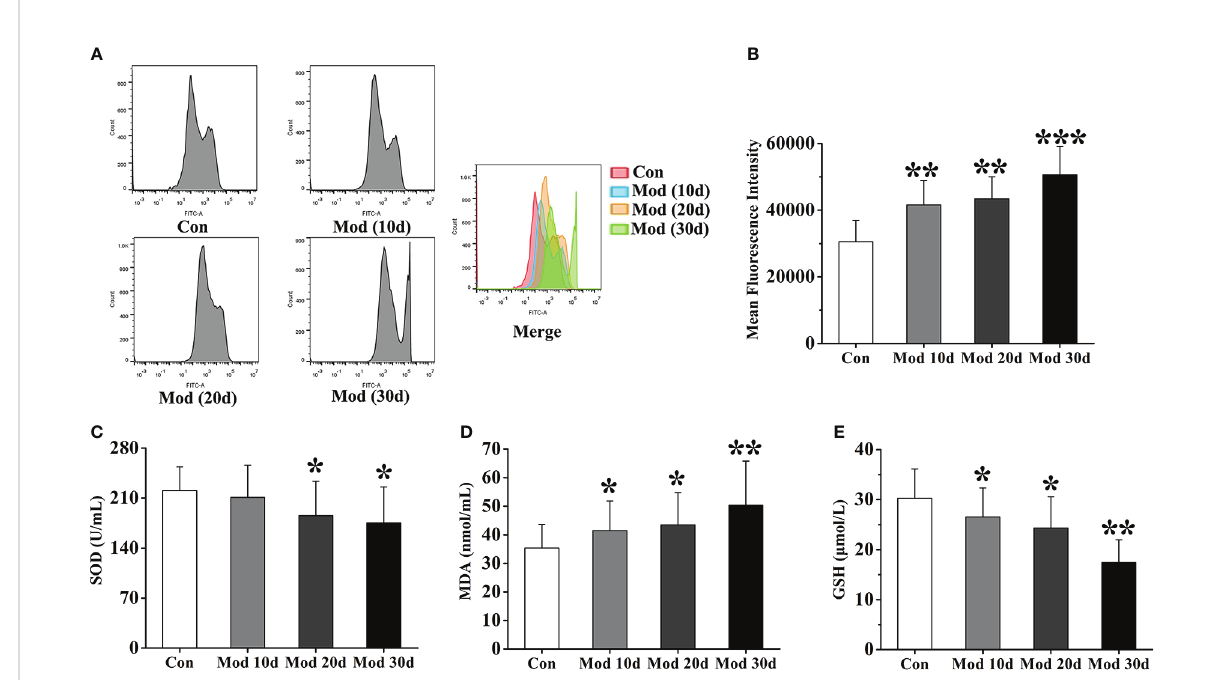
FIGURE 6 The level of oxidative stress in the joint synovial tissue of quails at different experimental stages. (A) Detection of ROS expression levels in the joint synovial tissue by fl ow cytometry. (B) The mean fl uorescence intensity of the joint synovial tissue. in each group. (C) The content of SOD in the joint synovial tissue. (D) The content of MDA in the joint synovial tissue. (E) The content of GSH in the joint synovial tissue. Data are expressed as mean ± SEM for 8 quails in each group. * P < 0.05, ** P < 0.01 and *** P < 0.001 versus Con